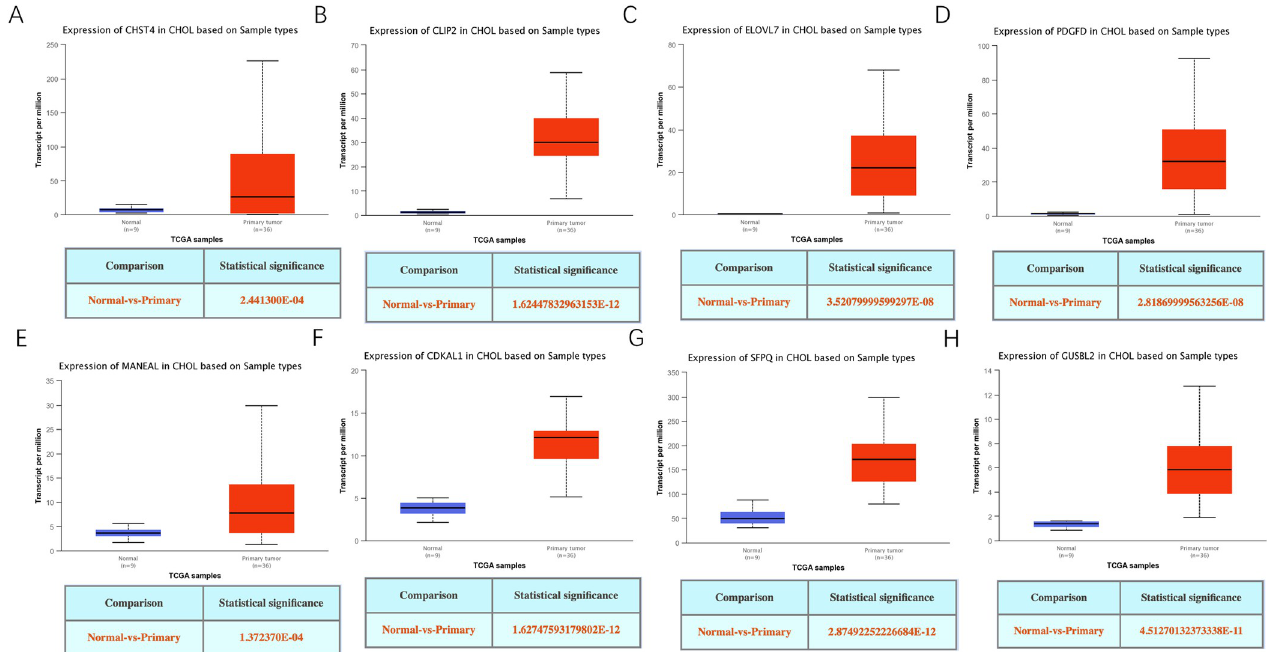
Fig 4. Expression profiles of genes from the UALCAN. (A) expression profiles of CHST4, (B) expression profiles of CLIP2, (C) expression profiles of ELOVL7, (D) expression profiles of PDGFD, (E) expression profiles of MANEAL, (F) expression profiles of CDKAL1, (G) expression profiles of SFPQ, (H) expression profiles of GUSBL2.